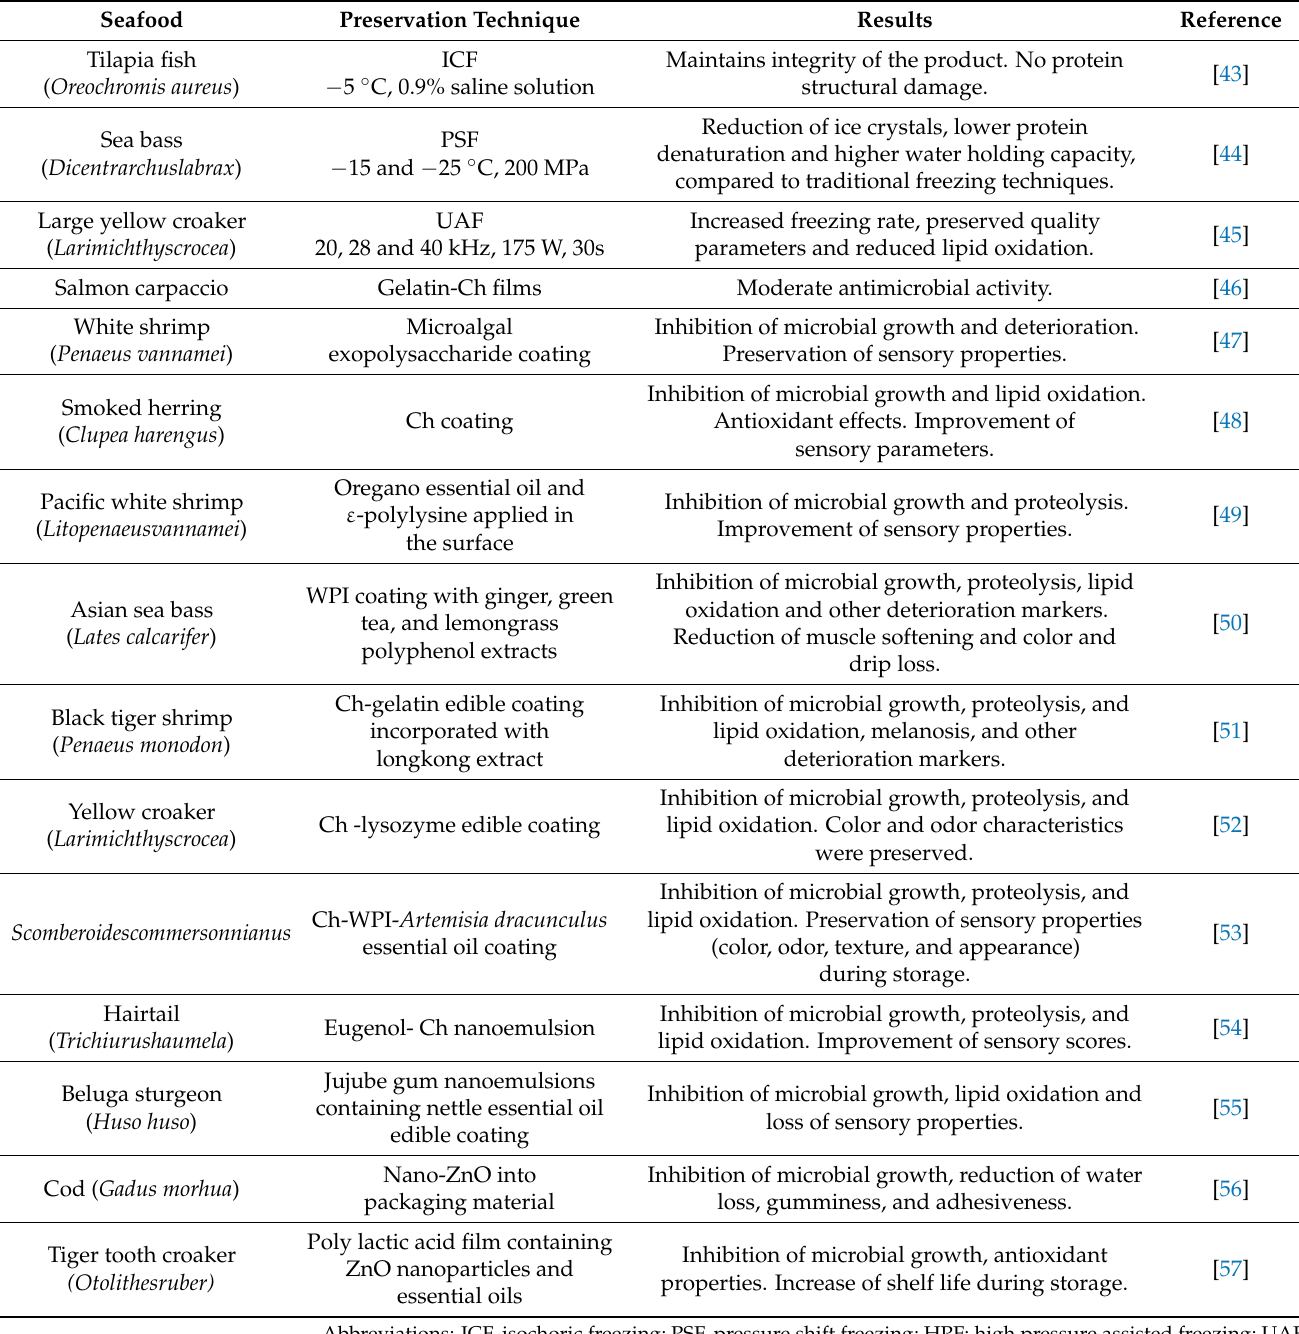
Table 2. Examples of studies applying current trends in seafood preservation